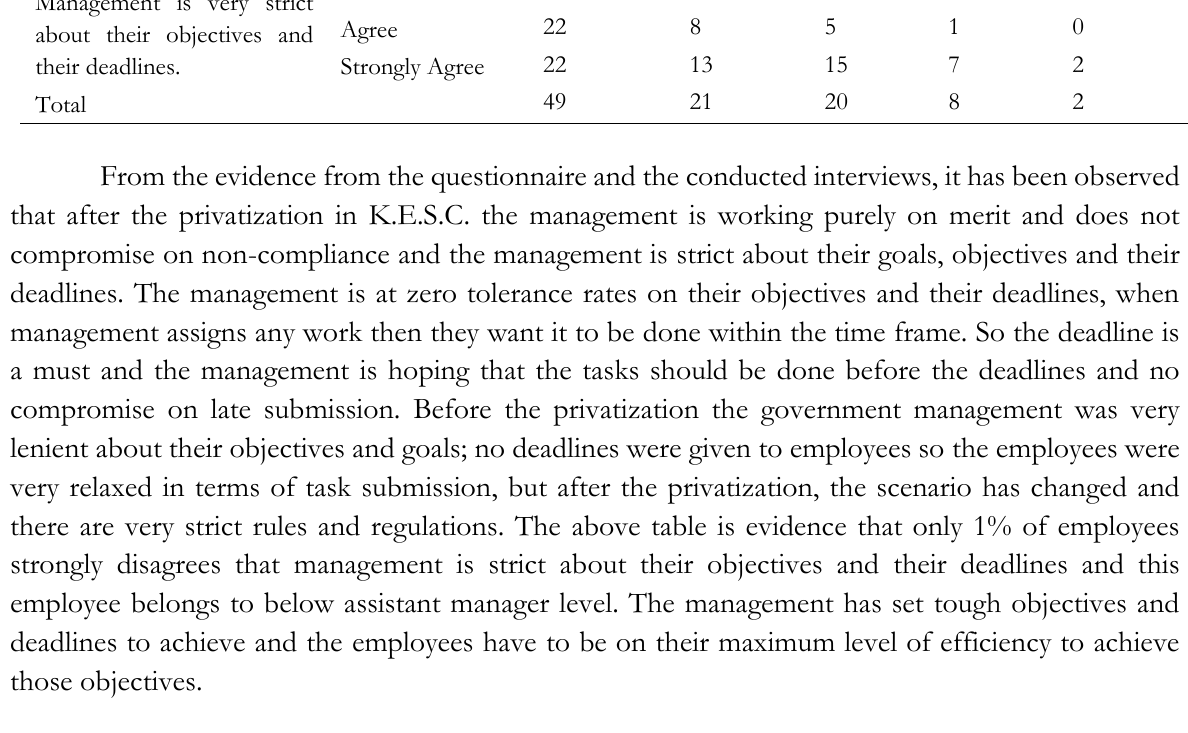
Table 1: Q2 * DSG Cross tabulation Management is very strict about their objectives and their deadlines.